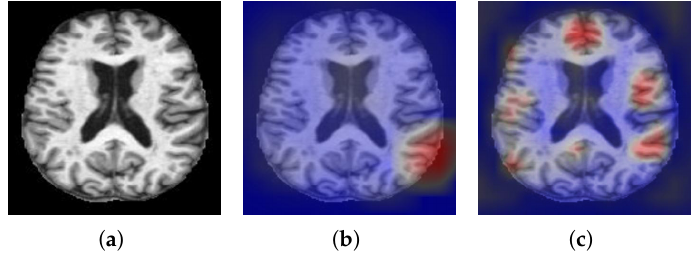
Figure 9. Visual comparison ( a ) Input image. ( b ) WSDAN. ( c ) WS-AMN.